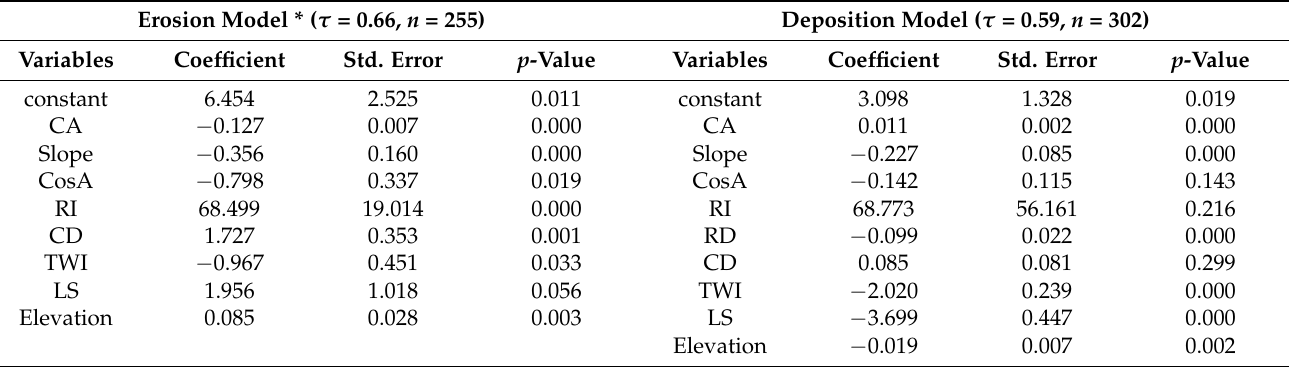
Table 6. Coefficients of the QR models for erosion and deposition (March–June 2015).